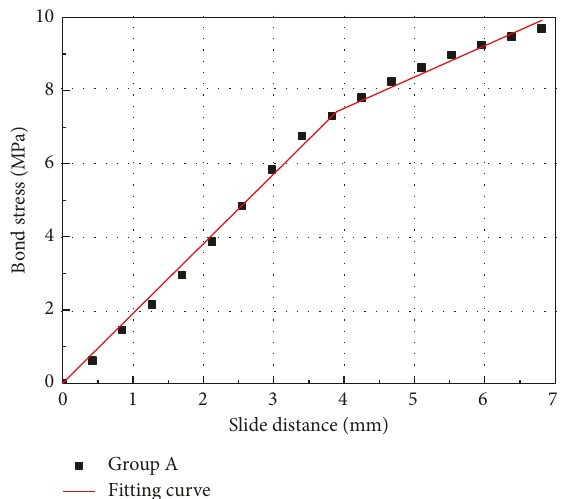
Figure 14: The bond-slide fitting curve of the uncorroded specimen in group A.